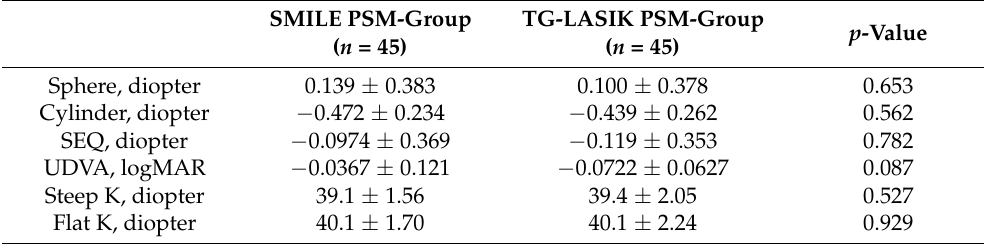
Table 2. Comparison of postoperative refractive parameters between the two propensity-score- matched groups.